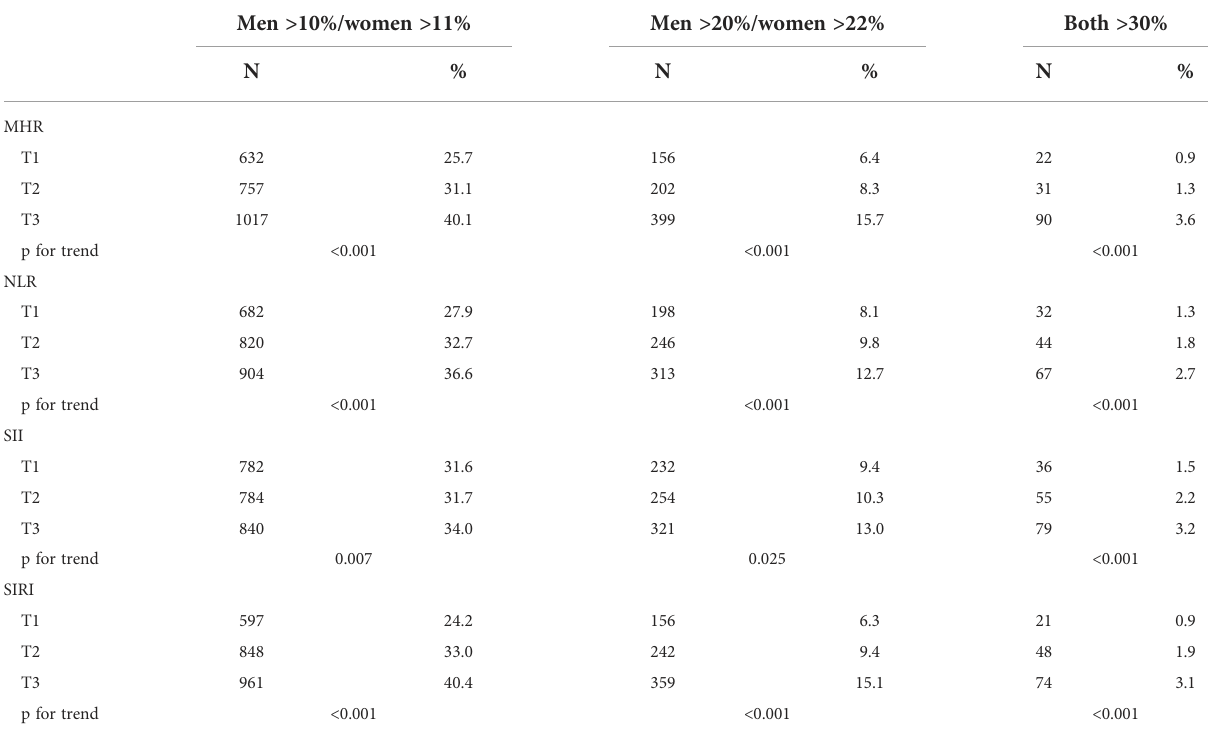
TABLE 5 Ten-year CVD risk re fl ected by FRS among different levels of multiple in fl ammation